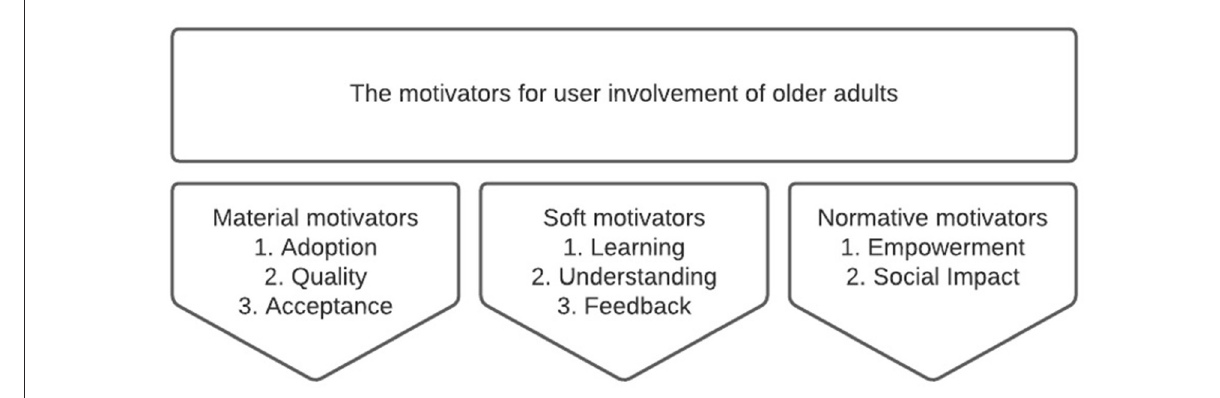
FIGURE4 Showing the motivators for older adults to be involved in user research according to Fischer et al. (2020).